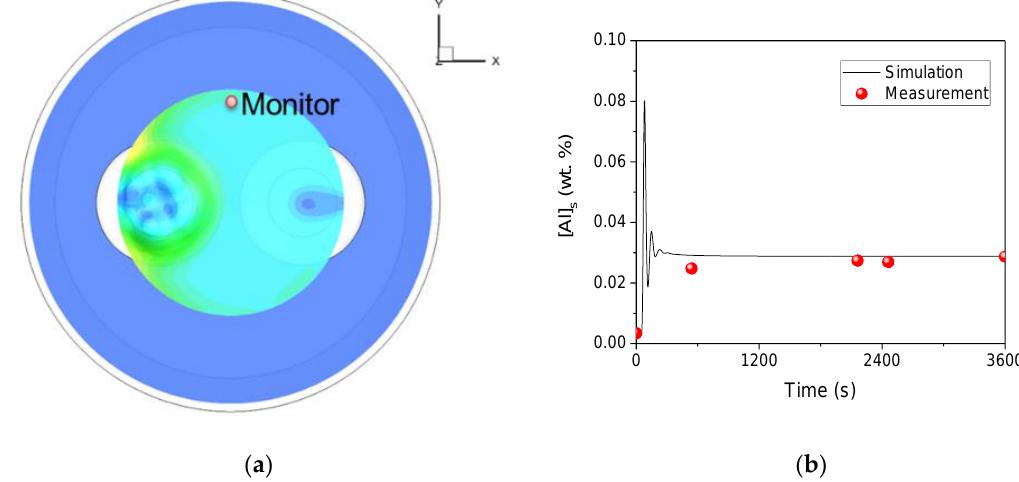
Figure 7. Comparison of measured and calculated dissolved aluminum in molten steel: ( a ) Sampling position; ( b ) model validation.